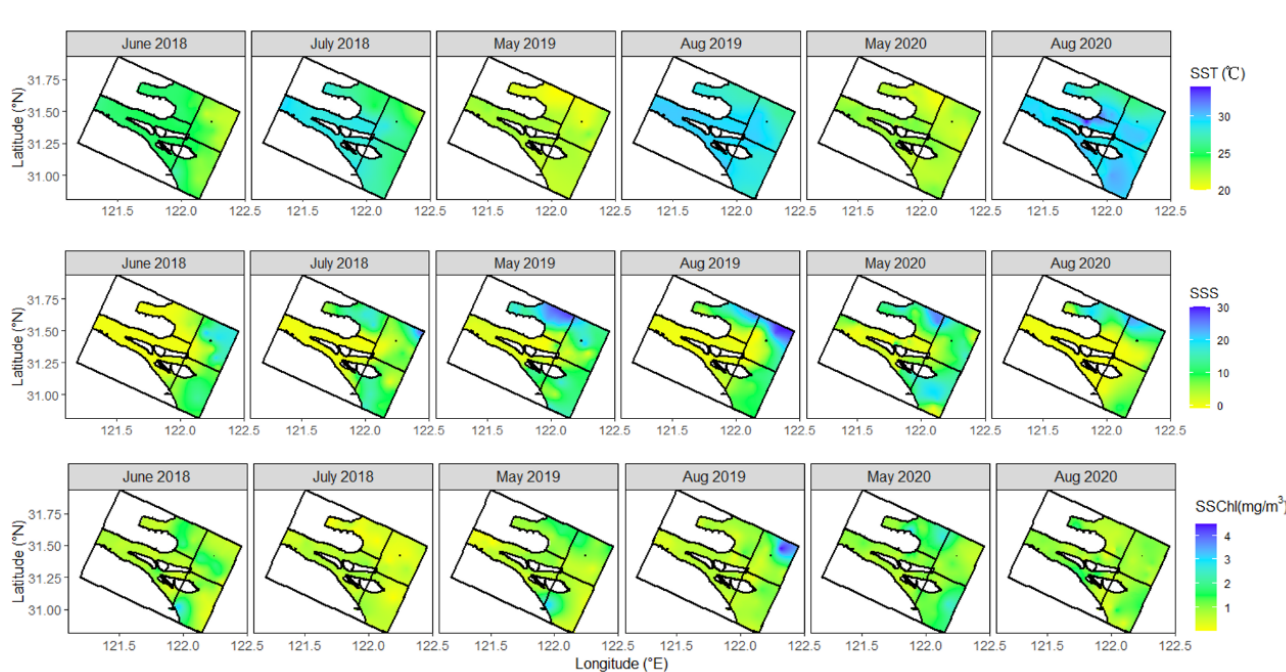
Figure 4. The distribution of environmental factors in the Yangtze Estuary (SST, sea surface temper- ature; SSS, sea surface salinity; SSChl, sea surface chlorophyll a). Table 1. Mean values for depth (Dep, m), sea surface temperature (SST, °C), sea surface salinity (SSS), and sea surface chlorophyll a (SSChl, mg/m 3 ) sampled during six cruises in the Yangtze Estu- ary (±95% confidence interval).